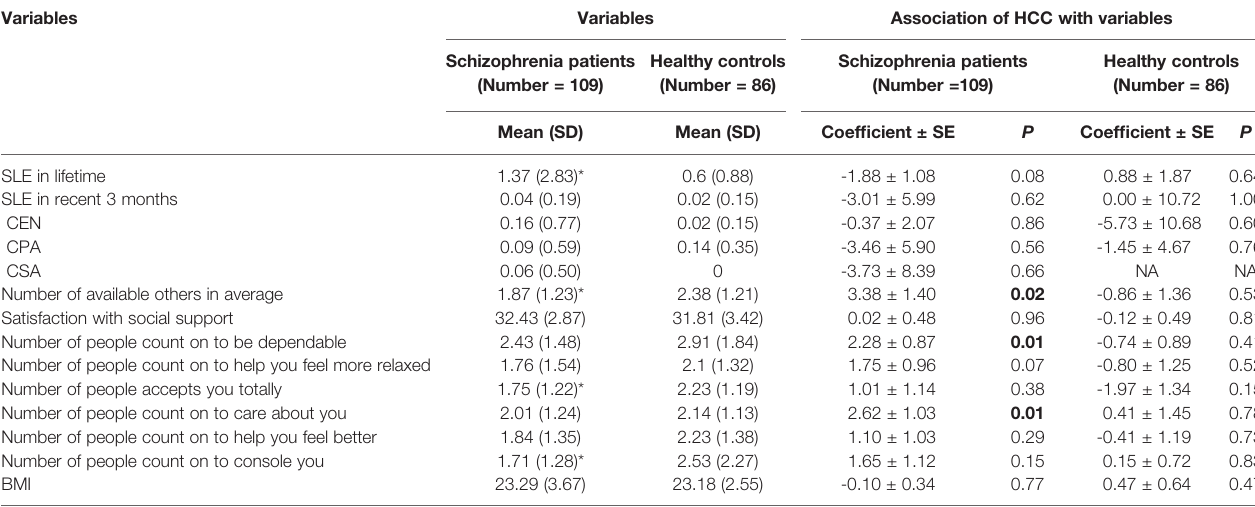
HCC,haircortisolconcentrations;SLE,stressfullifeevents;CEN,childhoodemotionalneglect;BMI,bodymassindex;CSA,childhoodsexualabuse;CPA,childhoodphysicalabuse; SD, standard deviation; SE, standard error, *P < 0.05 (compared with healthy controls). The bold values are signi fi cant with a p-value <0.05.